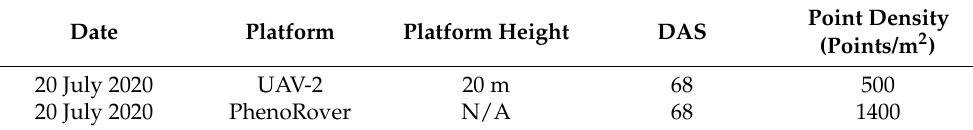
Table 5. Ground point density of sorghum over SbDivTc_Cal sorghum